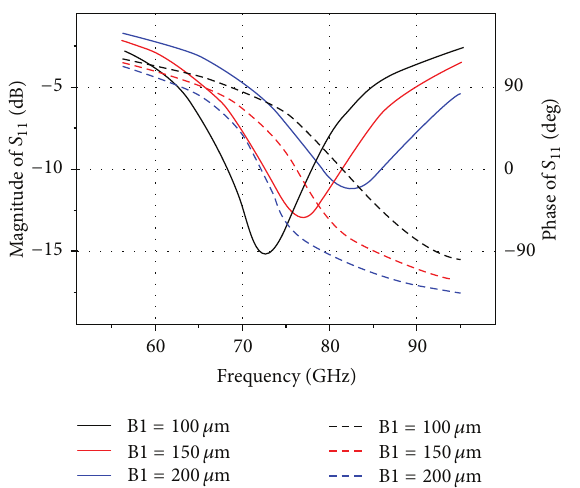
Figure 7: Magnitude and phase of reflection coefficient versus geometrical parameter B1.